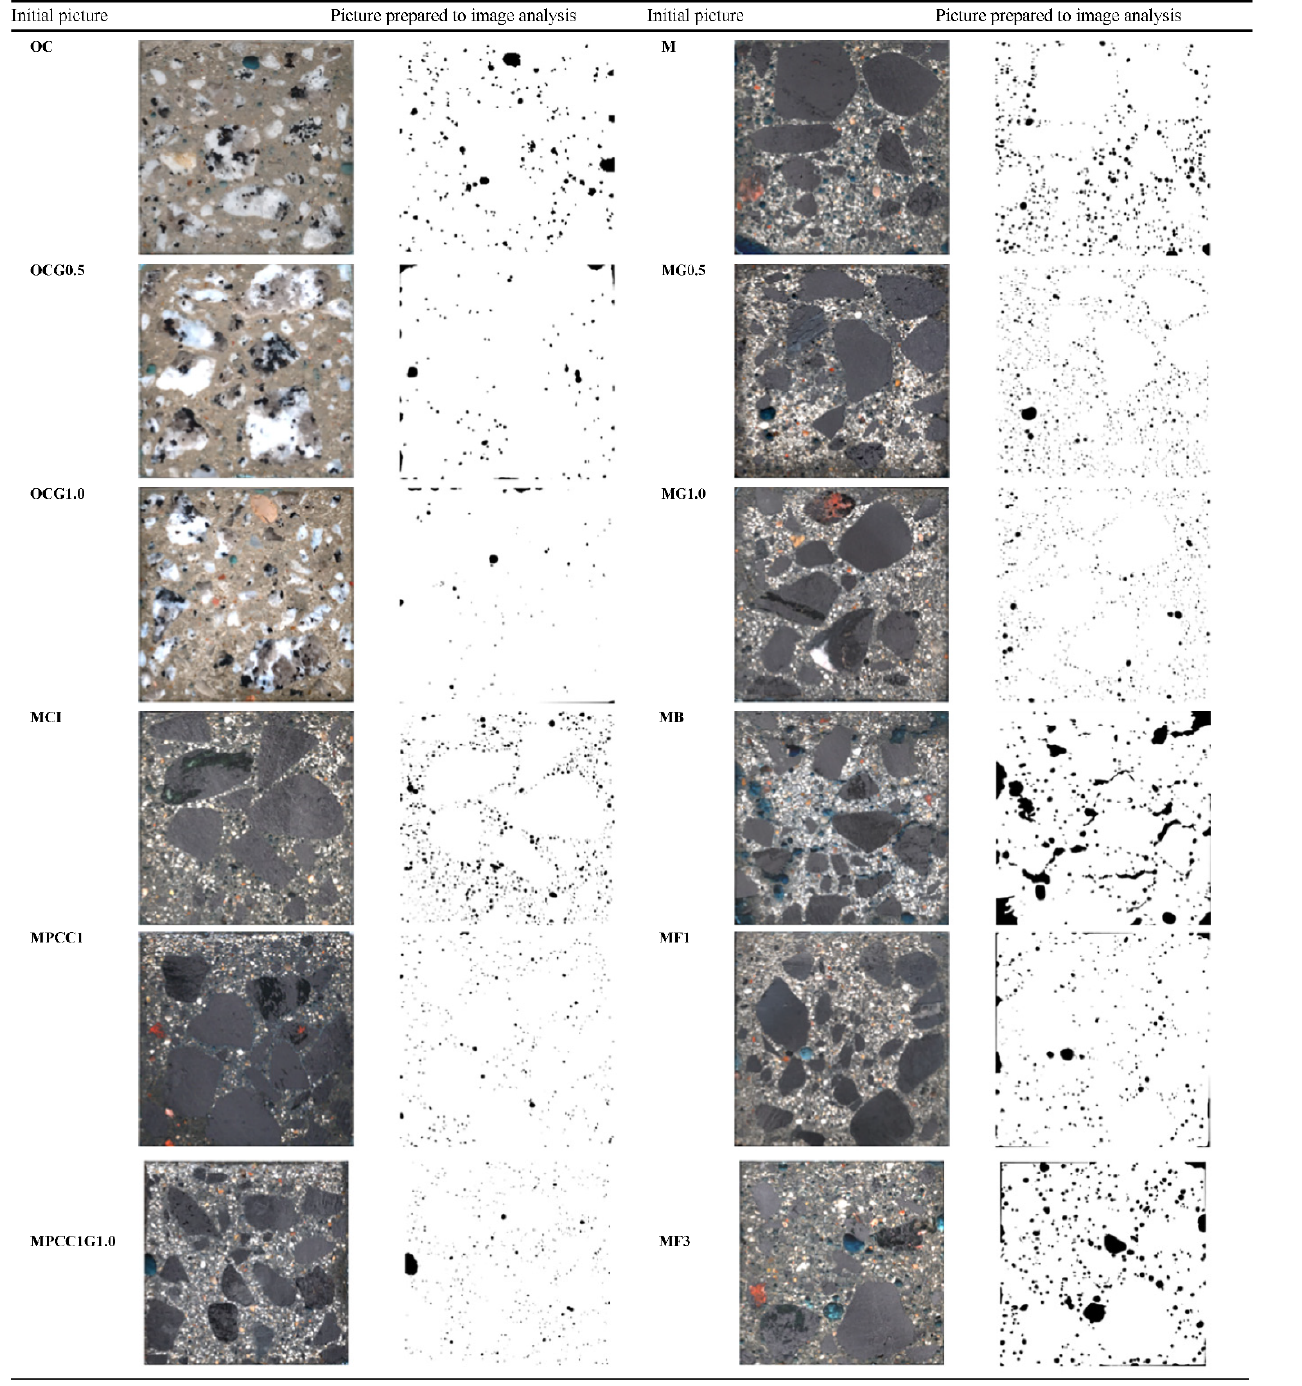
Figure 12. Mean porosity (V v ) computed by image analysis with variation coefficients (CV, CV 2 ), and without/with air void contribution of ≥ 2 mm (V v2 ) (adapted from [163]).